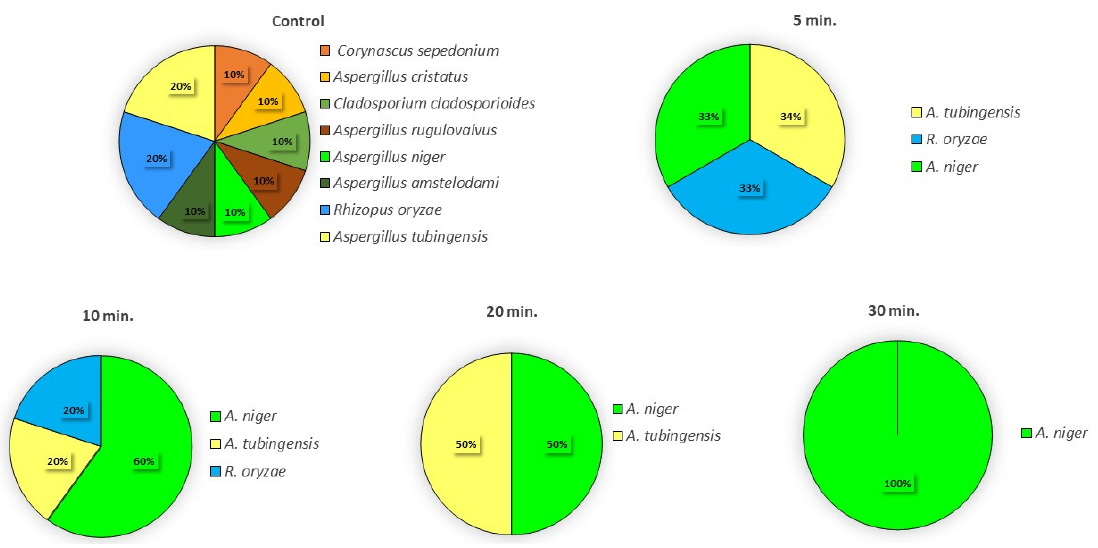
Figure 1. Incidence of the fungal species on sundried tomatoes before and after the ACP